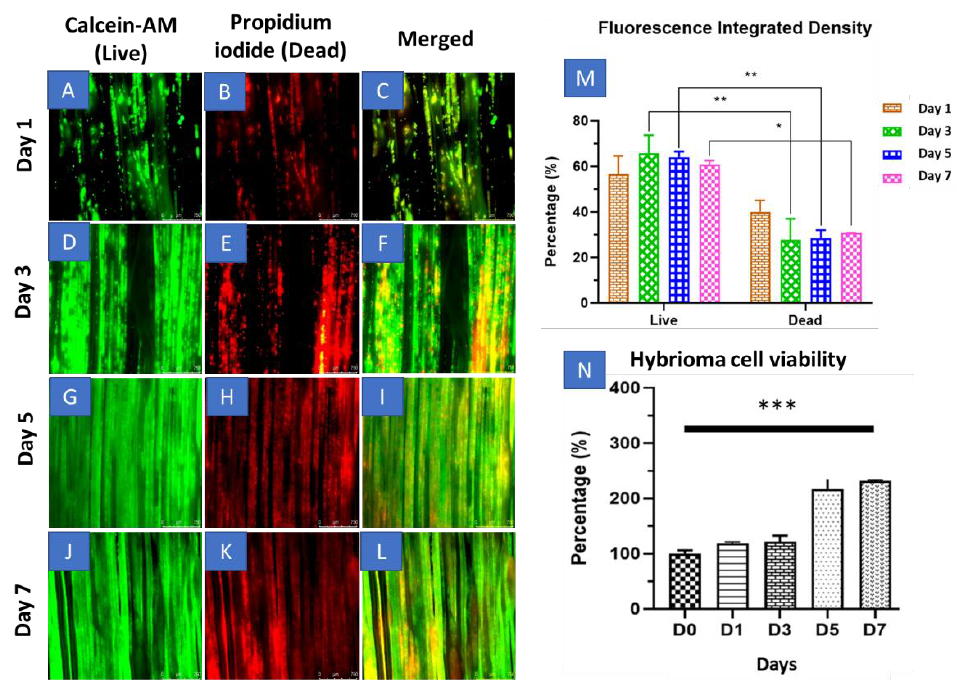
Figure 2. ( A – L ) Fluorescence microscopy (4 × magnification) of Live-Dead stain of hybridoma cells loaded within PSF MTAMs at day 1 ( A – C ), day 3 ( D – F ), day 5 ( G – I ) and day 7 ( J – L ). ( M ) Total fluorescence density of hybridoma cells loaded within the PSF MTAMs at day 7, which revealed significantly higher live hybridoma cells than the dead hybridoma cells. ( N ) Overall viability of hybridoma cells assayed with MTT assay which revealed statistically significant increase between the readings on day 0 versus the viability on day 7. Two-way ANOVA with Sidak’s multiple comparisons tests. * p < 0.05, ** p < 0.01, *** p < 0.001. Error bars in data represented + −⁄ 𝑆𝐷 . ( n = 3).